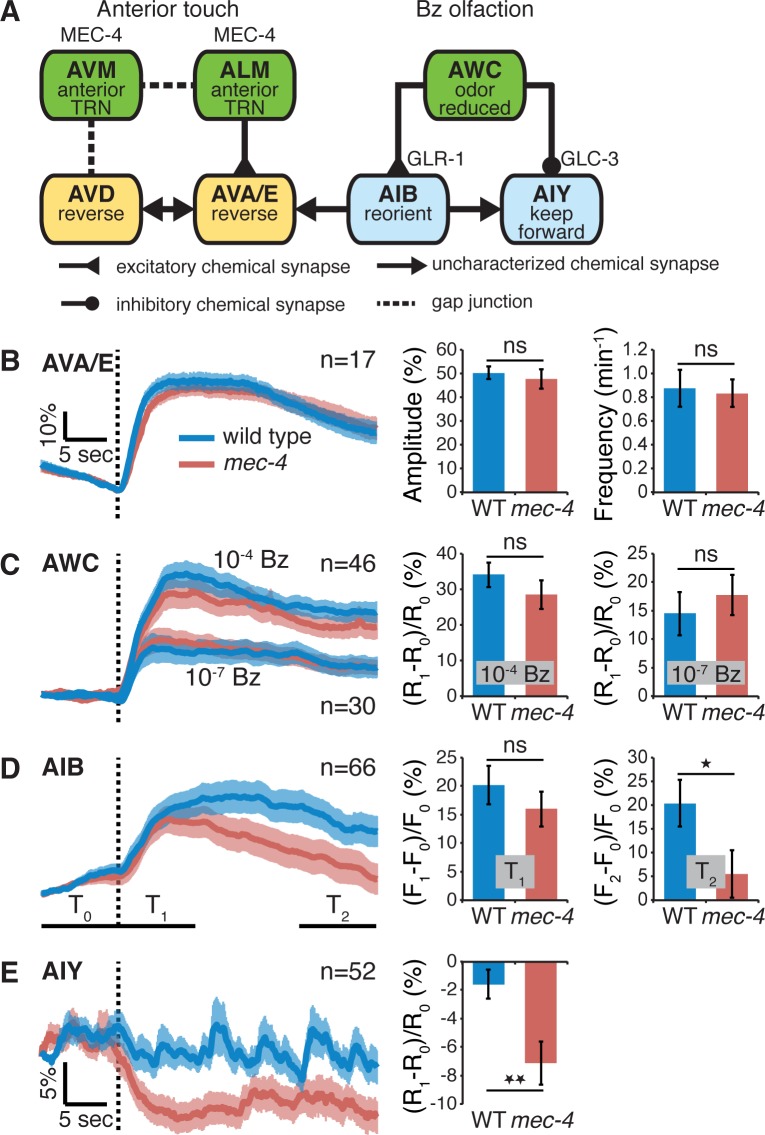
Loss of body touch results in increased inhibitory transmission between AWC and AIY.(A) Principal neurons comprising the body touch mechanosensory circuit (left) and Bz-sensing olfactory circuit (right). Indicated are synapse types and synaptic receptors in AIB and AIY. (B) Averaged trace (left), amplitude (middle), and frequency (right) of spontaneous calcium transients recorded in AVA/E. (C–E) Averaged trace (left) and mean ratio (C and E) or fluorescence (D) change (middle and right) before and after 1:10,000 Bz removal (dotted line) recorded in AWC (C), AIB (D), and AIY (E) neurons in wild-type (N2) and mec-4(u253) mutants. AWC (C) was also tested with a lower concentration of Bz (1:10,000,000; ratio change—right). T0, T1, and T2 in D indicate the averaging windows for computing fluorescence: F0 and R0 are fluorescence, and ratio change averaged over T0. F1 and R1 are averages over T1. F2 is the average over T2. The AIB response to Bz removal was attenuated (D). The AIY response to Bz removal was augmented (E). Sample size is indicated in each panel; Error bars represent SEMs; *p < 0.05, **p < 0.01 t test.